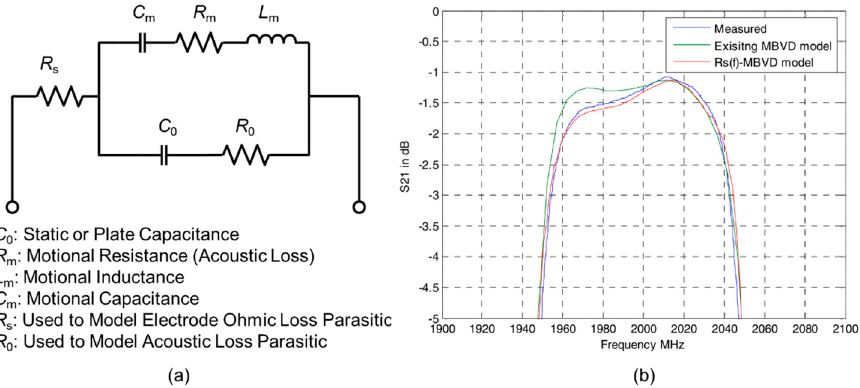
Figure 3. ( a ) Modified Butterworth Van Dyke (MBVD) model [8]. ( b ) Measured filter data of R s ( f ) ‐ MBVD model, reproduced with permission from [9].